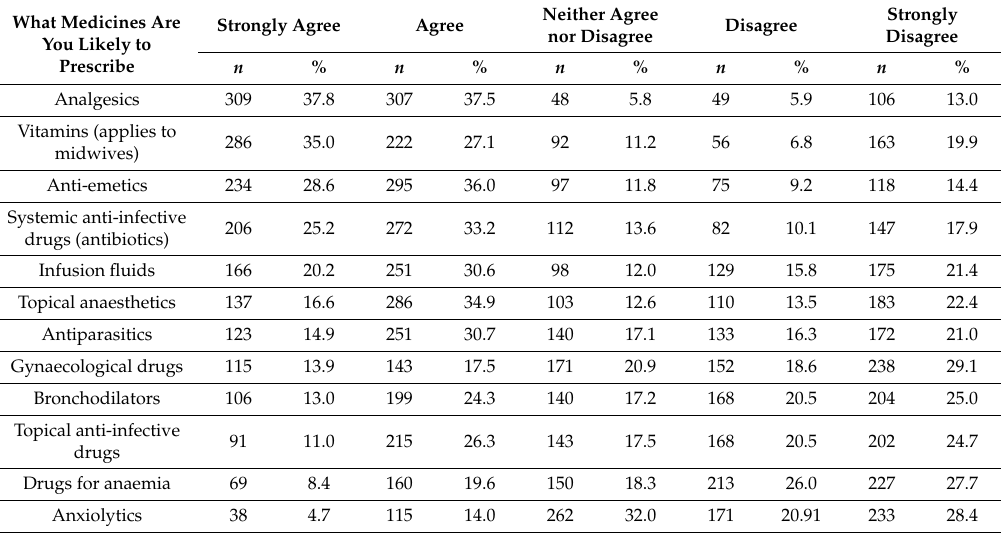
Table 4. Types of medicinal products that the respondents anticipated